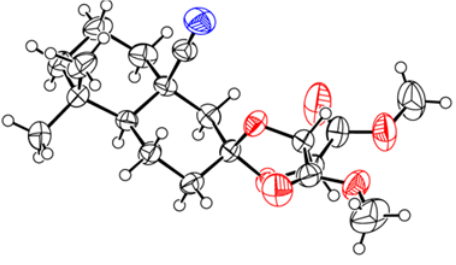
Figure 3. Oak ridge thermal ellipsoid plot ( ORTEP) of compound (−)- 8 .